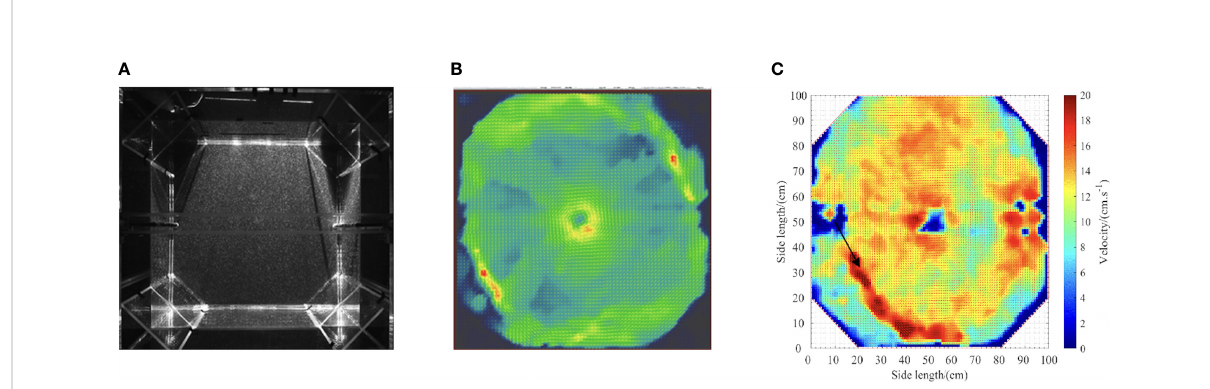
FIGURE 6 Image processing of PIV data: (A) Raw PIV image; (B) Preliminary treatment; (C) Re fi ned treatment.